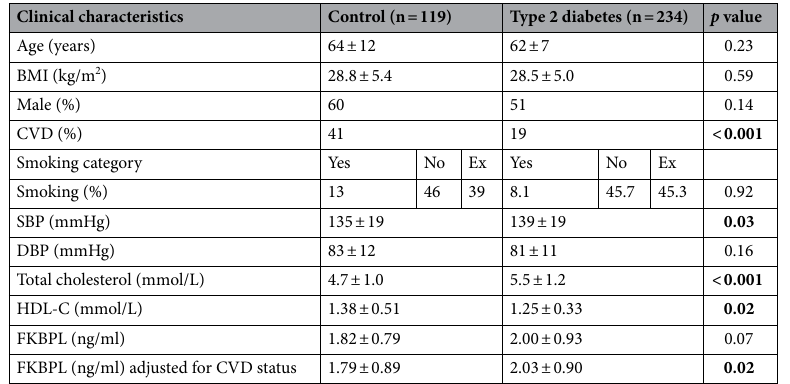
Table 1. Clinical characteristics of control and type 2 diabetes groups. Continuous data are expressed as mean (standard deviation) and categorical data as the number of subjects (%). p values < 0.05 (statistically significant). Independent samples t-tests and χ 2 tests were used as appropriate. HDL-C: High-density lipoprotein cholesterol; SBP: Systolic blood pressure; DBP: Diastolic blood pressure. p values <0.05 are in